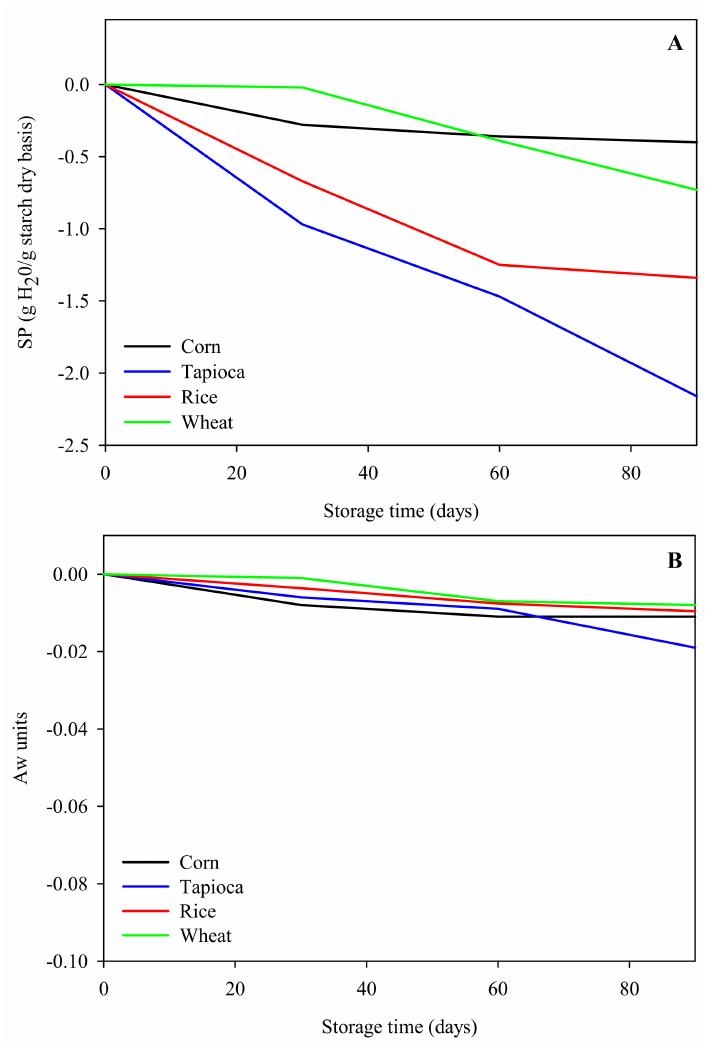
Figure 2. Influence of storage time on the swelling power ( A ) and A w ( B ) values of starch-based HPP